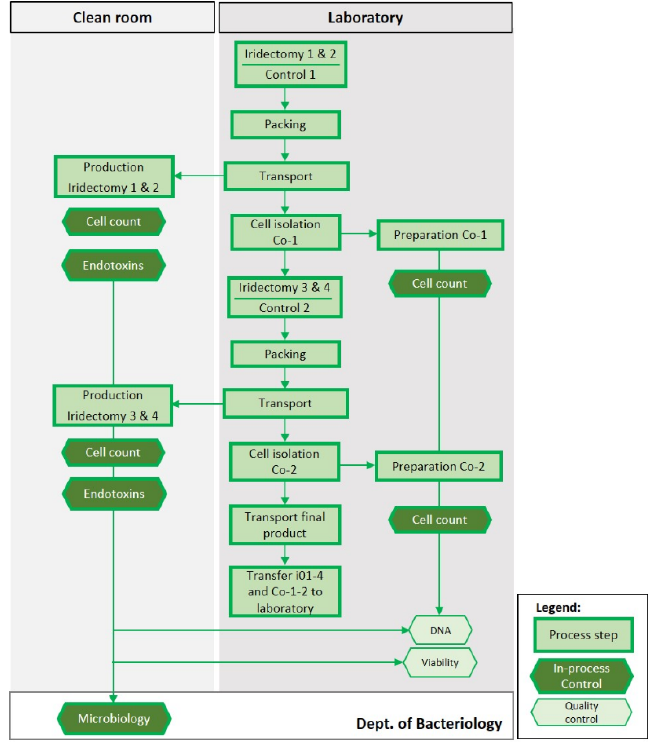
Figure 4 . Flow chart of the ValRun. Iris i01–i04 and control biopsies (Co ‐ 1 and ‐ 2) were obtained Figure 4. Flow chart of the ValRun. Iris i01–i04 and control biopsies (Co-1 and -2) were obtained from post ‐ mortem human donor eyes; biopsies i01, i02, 103, and i04 were packaged and transported from post-mortem human donor eyes; biopsies i01, i02, 103, and i04 were packaged and to the LTTC. The operator and the assistant manufactured tIPE 1 and 2 and separately tIPE 3 and tIPE 4, and prepared the samples for QC, which included cell count, endotoxin levels, microbiology, remnant extracellular DNA, and cell viability. In the laboratory, Co ‐ 1 and Co ‐ 2 were processed sim ‐ ilar to i01 ‐ 2 and i03 ‐ 4 but under research laboratory conditions and without transfection. Stroma and supernatant of i01 ‐ i04 were submitted for microbiological analysis. tIPE1 ‐ tIPE4 were trans ‐ ported back to the laboratory, where also the remnant extracellular DNA and cell viability (also for Co ‐ 1 and ‐ 2) were analyzed. 3.3.2. Process Optimization and Definition of Release Criteria After an interim analysis, the first 39 productions were defined as “training phase” used to optimize the process, define release criteria and train personnel. This was followed by the subsequent 104 validation productions. Since microbiological analysis requires a minimum of 5 days, it is not possible to obtain microbiological results for the proposed treatment that requires cell transplantation within approximately 60 min from biopsy to transplantation. However, the microbiological analysis has been and will be necessary for therapeutic decisions in the unlikely case that an infection would occur post ‐ transplanta ‐ tion. Table 4 details the specifications and QC performed during production and required for batch release. Apart from the QC reported above, all starting material was analyzed for completeness and validity. To deliver maximal data in the validation, it has been de ‐ cided to continue the production under circumstances that may lead to a stop of the pro ‐ duction in the clinical trial.